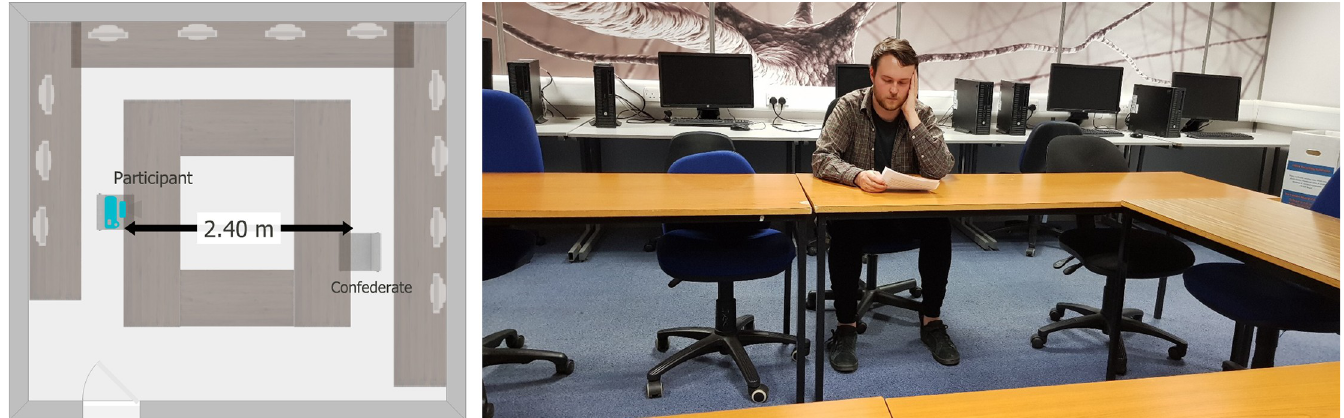
Fig 1. a . The room setup, showing location of the participant on the left and position of the confederate when seated, on the right. The door from which the confederate entered is shown at the bottom left. Figure is not drawn to scale. b . Reference image used to define participants’ gaze behaviour, showing the room layout. Image taken from the participants’ viewing